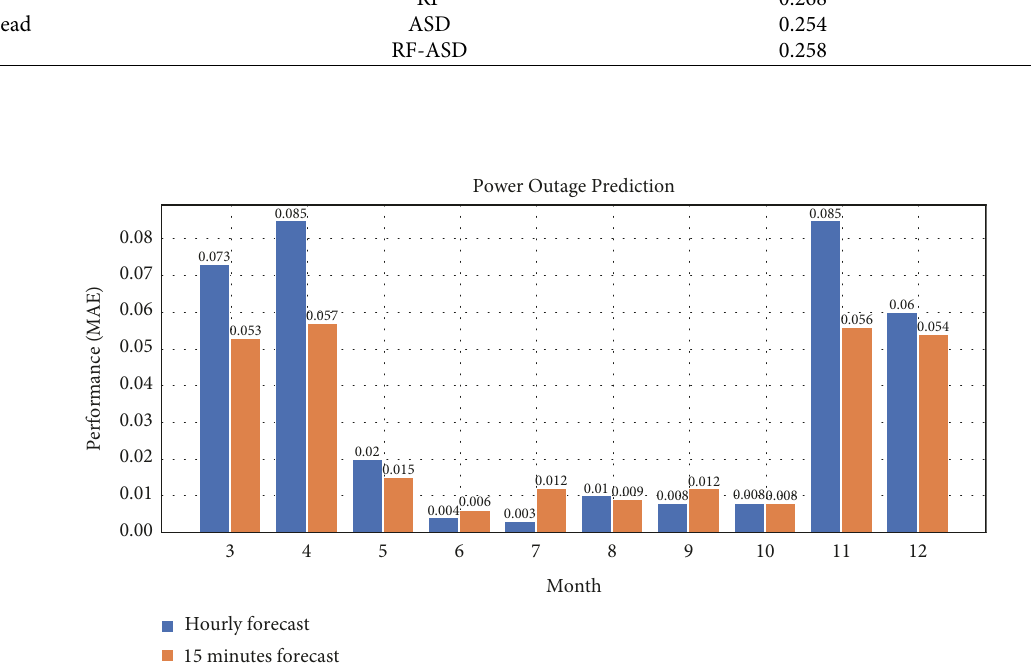
Figure 9: Performance of the RF-ASD blackout forecast model on different months’ data, considering the hour-ahead and 15-minutes ahead forecast horizons. March, April, November, and December had the most blackout events, thus affecting the performance of the blackout regression